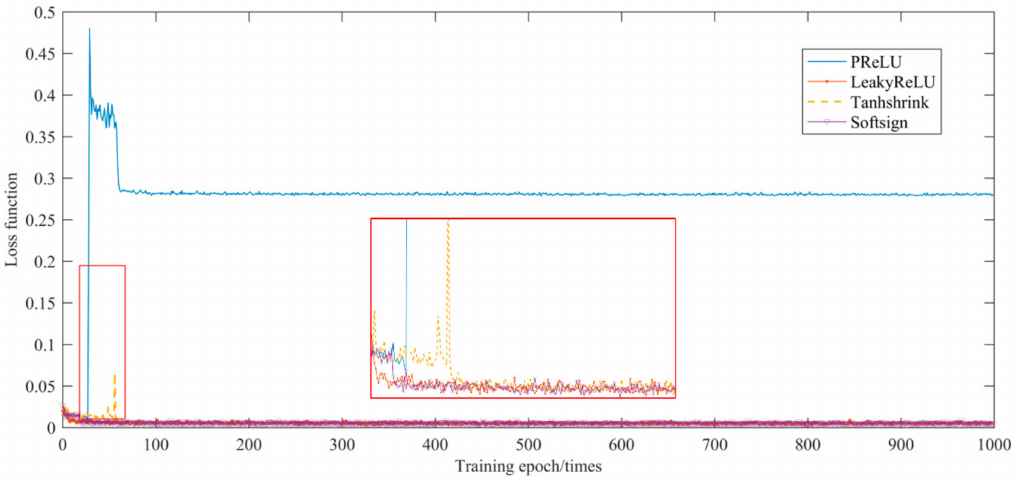
Figure 3. Changes of loss function with the number of iterations.